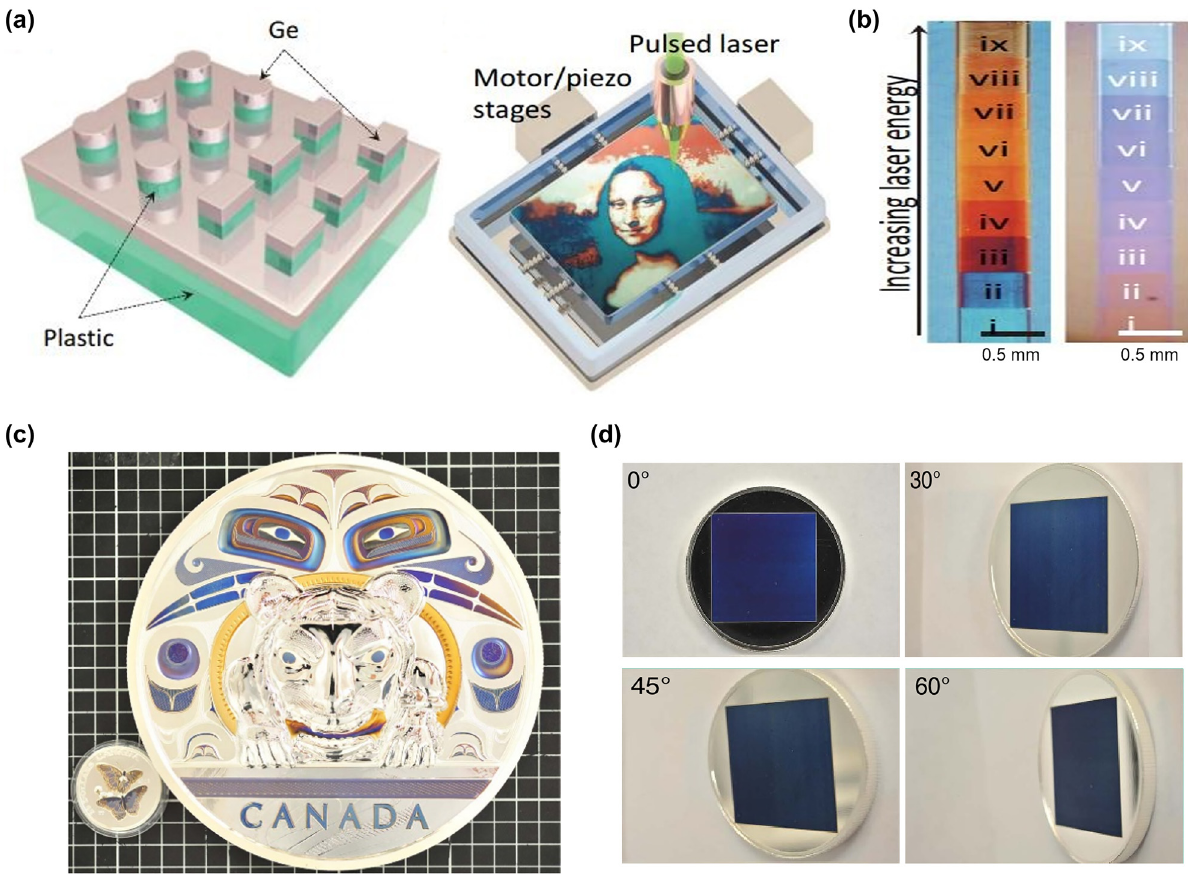
Figure 33: Dynamic structural color generation based on nanostructure geometric configuration modulation through laser post-writing. (a) Schematic illustrations of the Ge-based metasurface (left panel) and the setup of resonant laser printing (right panel). (b) Reflection-mode (left panel) and transmission-mode (right panel) microscope images of the fabricated structures (i to ix) by gradually increasing the laser power from 0.2 to 1.8 nJ with a step size of 0.2 nJ. Modified with permission [330]. Copyright 2017, American Association for the Advancement of Science. (c) Photo of a laser-colored 5 kg Ag coin. The diameter of the coin is 21 cm, and the thickness is 2.5 cm. Left corner shows the photo of an Ag coin (having topography variations of up to 2 mm in height) with laser-colored butterfly patterns. (d) Photos of a blue colored coin taken at four different viewing angles. Modified